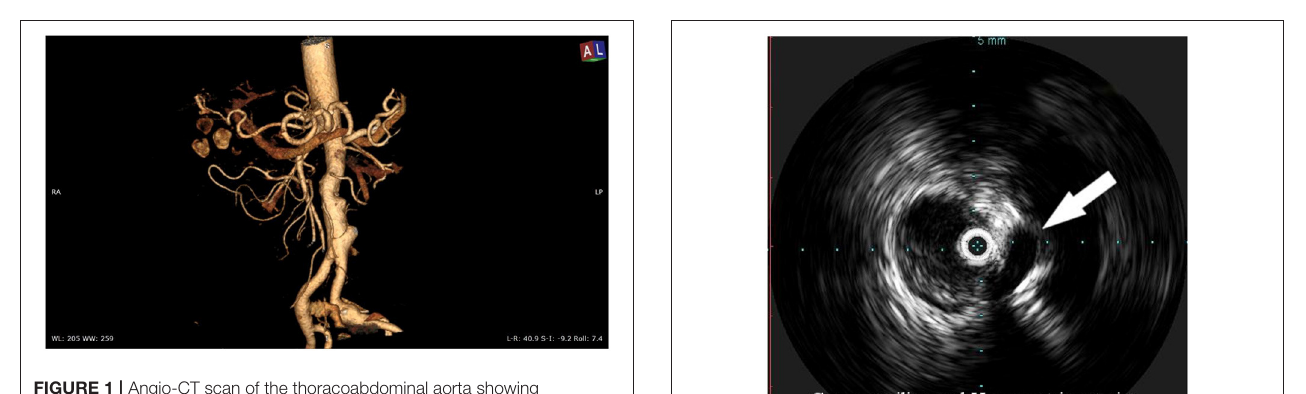
FIGURE 1 | Angio-CT scan of the thoracoabdominal aorta showing aneurysmal degeneration of penetrating aortic ulcers in the infrarenal aorta associated with lithiasis of the gallbladder.